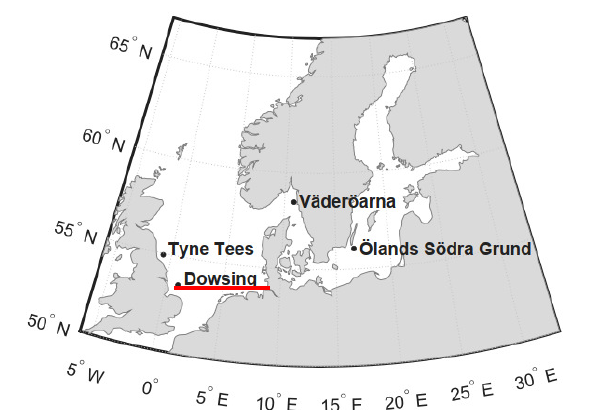
Figure 1. The four selected sites examined in [14] are shown. For the present study, the Dowsing site is selected, located in the North Sea; 56 km from the west coast of the United Kingdom, with water depth 22 m.